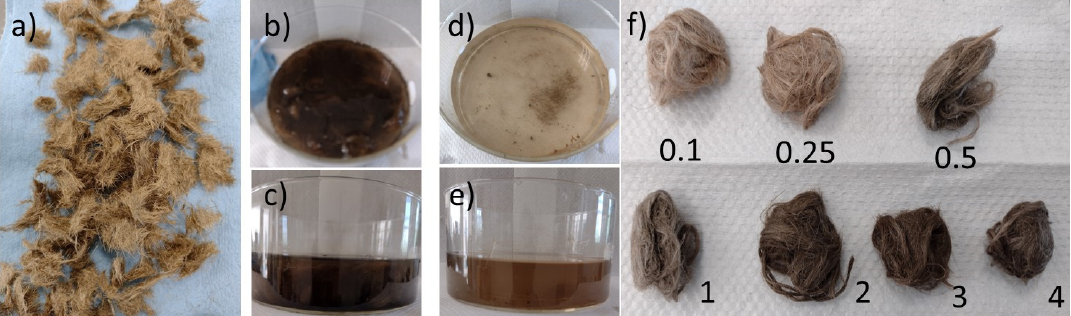
Figure 2. ( a ) Jute fibers washed and treated with NaOH, ( b ) and ( c ) impregnation of jute with nZVI/GO, ( d ) and ( e ) residue after impregnation for the 0.25 mL condition, ( f ) aspect of the impreg- nated